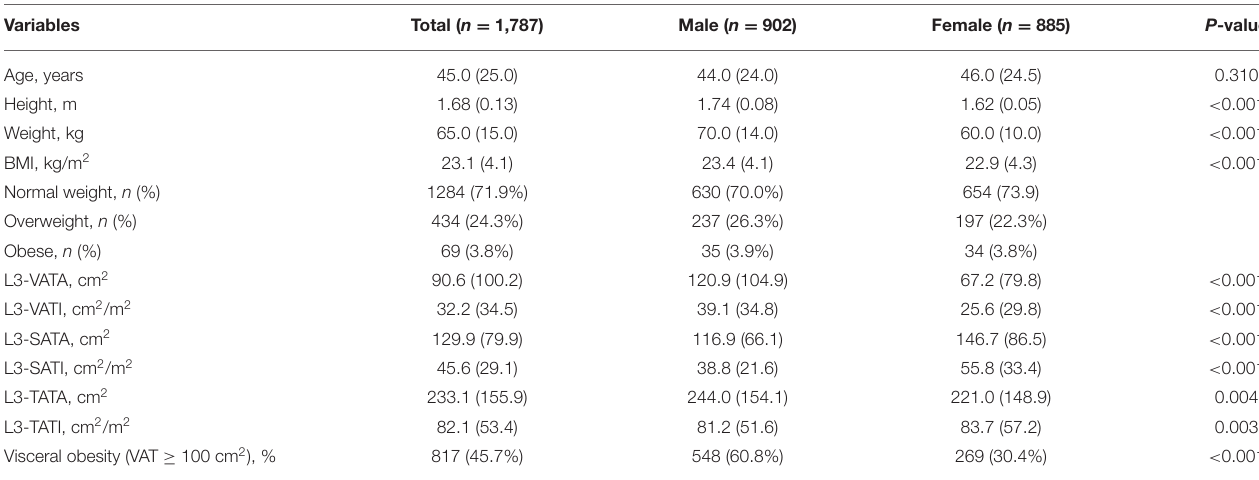
TABLE 1 | Baseline characteristics of the study population according to